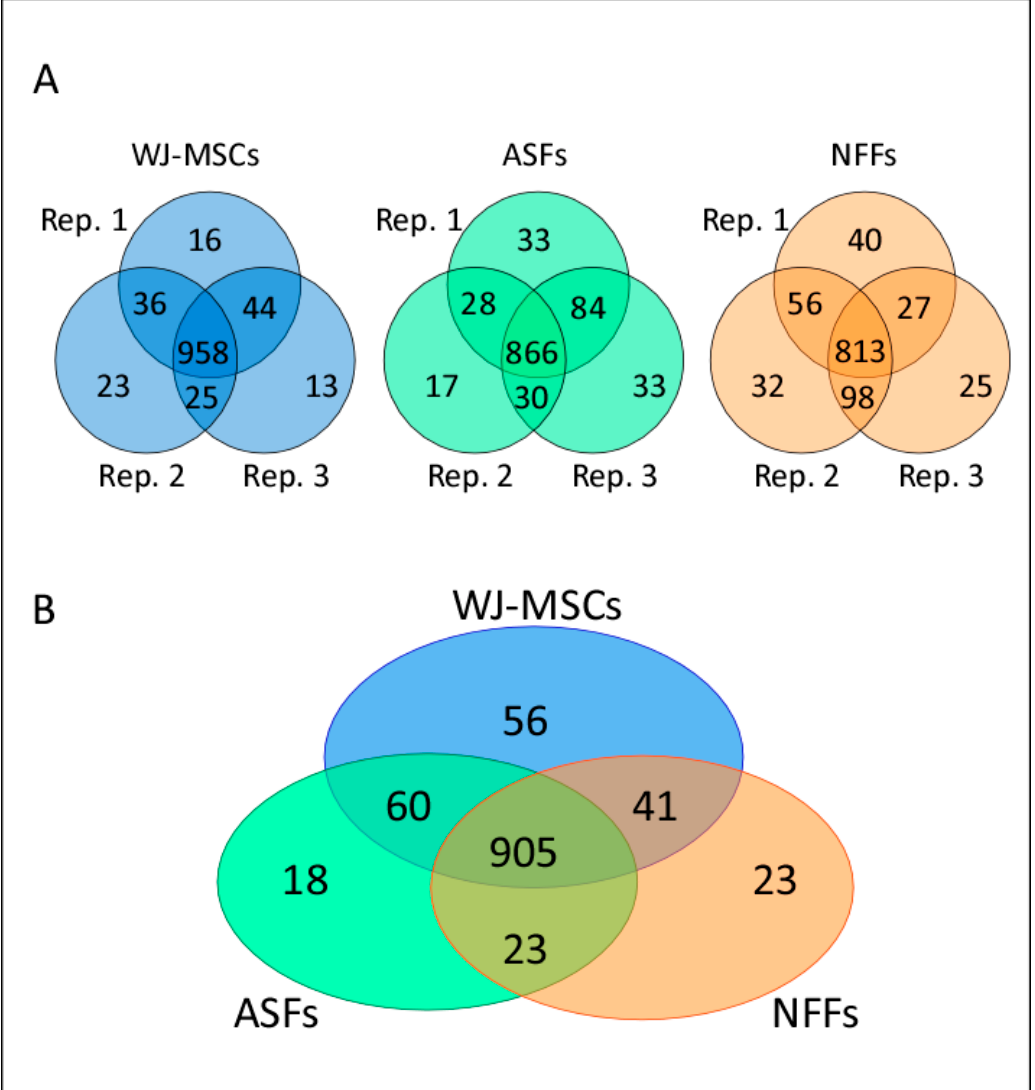
Figure 1. Proteomic analysis of WJ-MSCs, ASFs and NFFs. ( A ) A Venn diagram illustrating the number of proteins expressed by three different cell passages of WJ-MSCs, ASFs, and NFFs. For each cell type, the overlapping areas between the cell passage populations indicate the numbers of commonly expressed proteins. ( B ) A Venn diagram showing the number of proteins expressed by each cell type. The overlapping areas indicate the numbers of proteins commonly expressed by WJ-MSCs, ASFs, and NFFs, as identified by MS analysis. Rep, replicate.